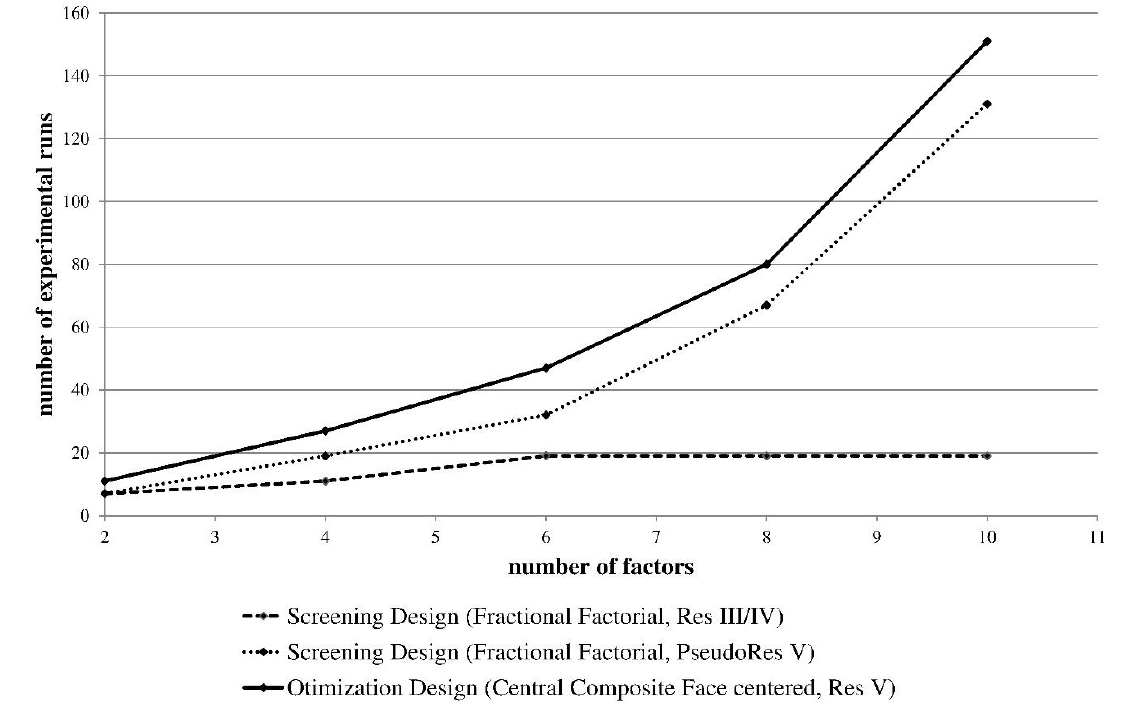
Figure 1. Correlation between the number of experimental runs and the number of investigated parameters. For optimization designs the number of runs increases exponentially while for screening designs the number of runs remains low for low resolution and increases significantly with the degree of